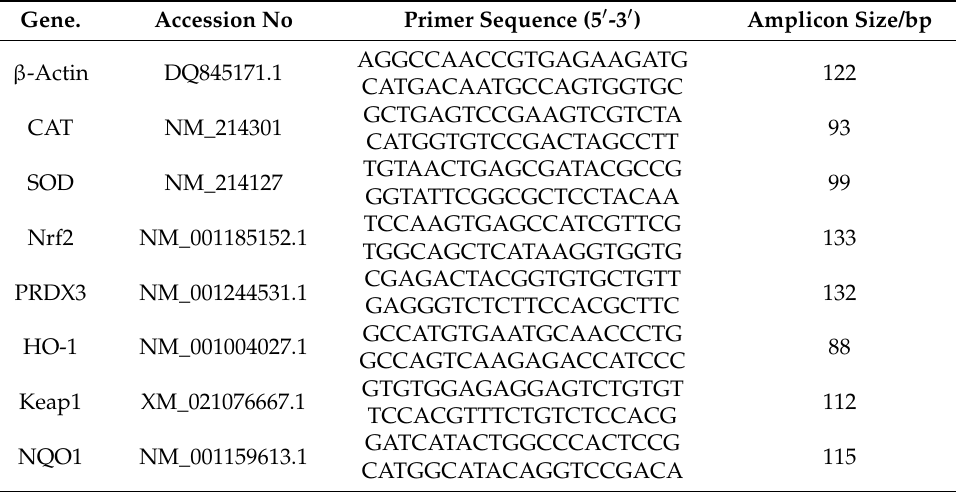
Table 2. Information of Quantitative Real-time PCR.